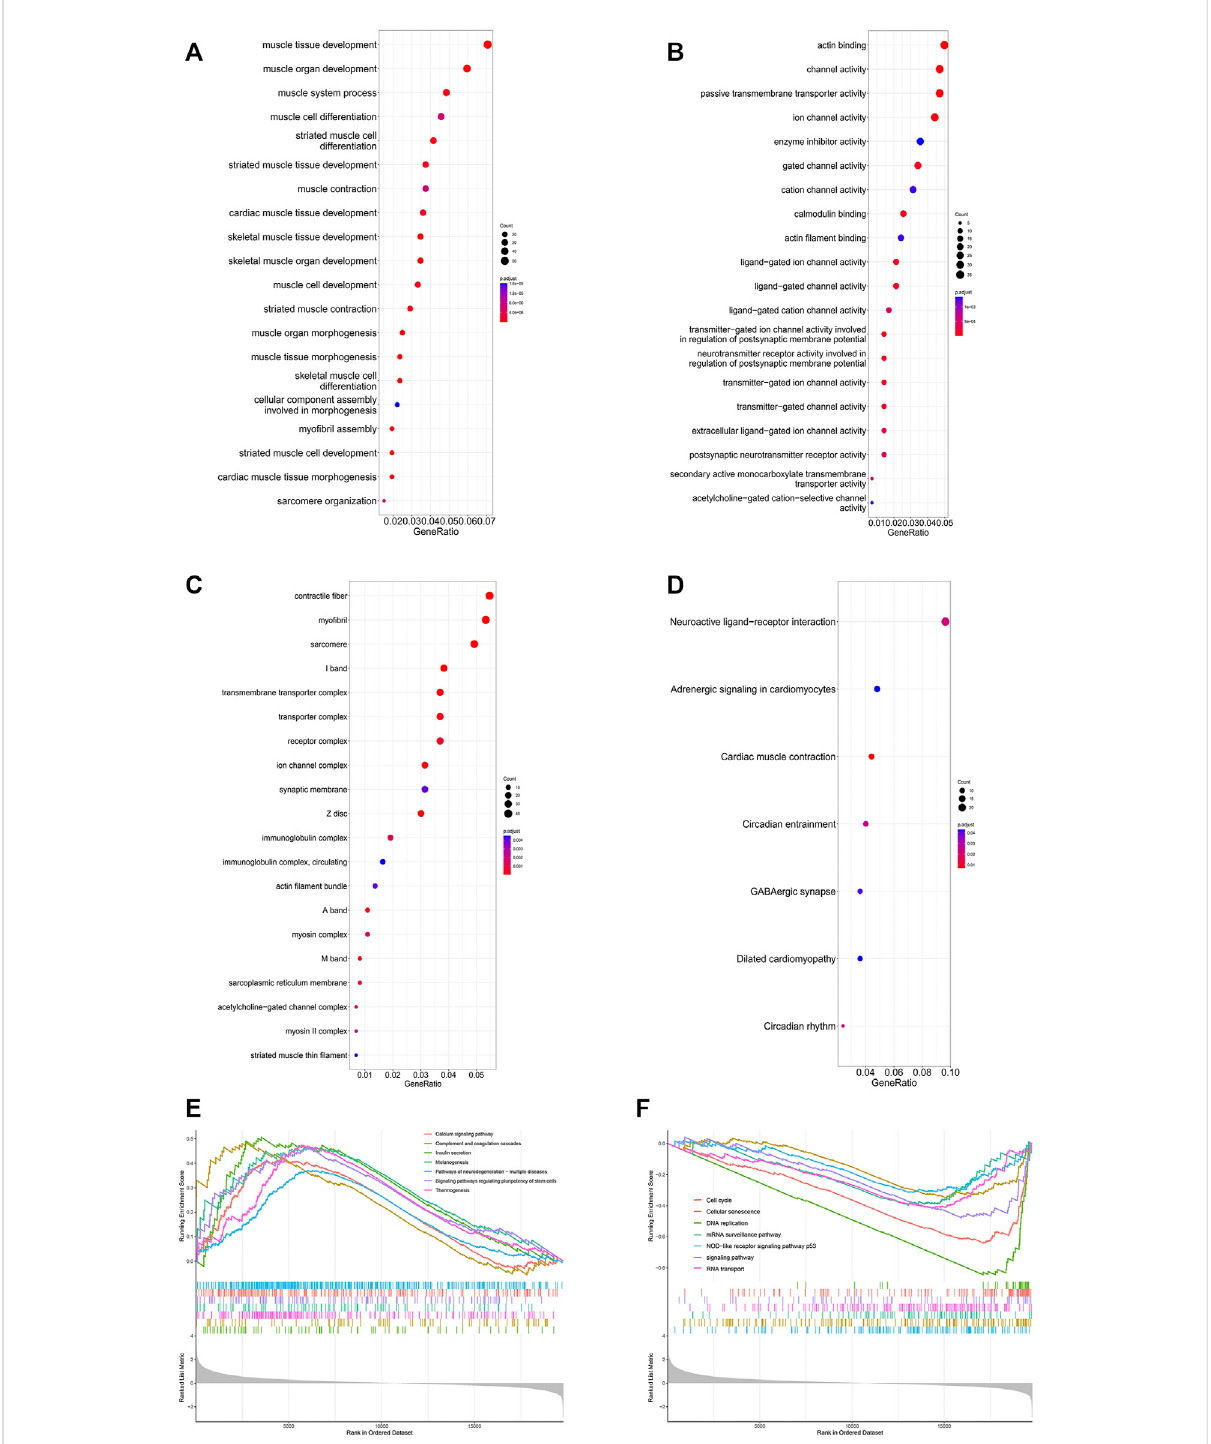
FIGURE 8 Enrichment analysis of DEGs in the SRP276872 dataset The top 30 BPs (A) , MFs (B) and CCs (C) in the GO analysis of DEGs are shown (D) KEGG analysis of DEGs. The size of the circle indicates the gene count. The color of the circles represents the adjusted p value (E) (F) Visualization of 14 of the 51 GSEA